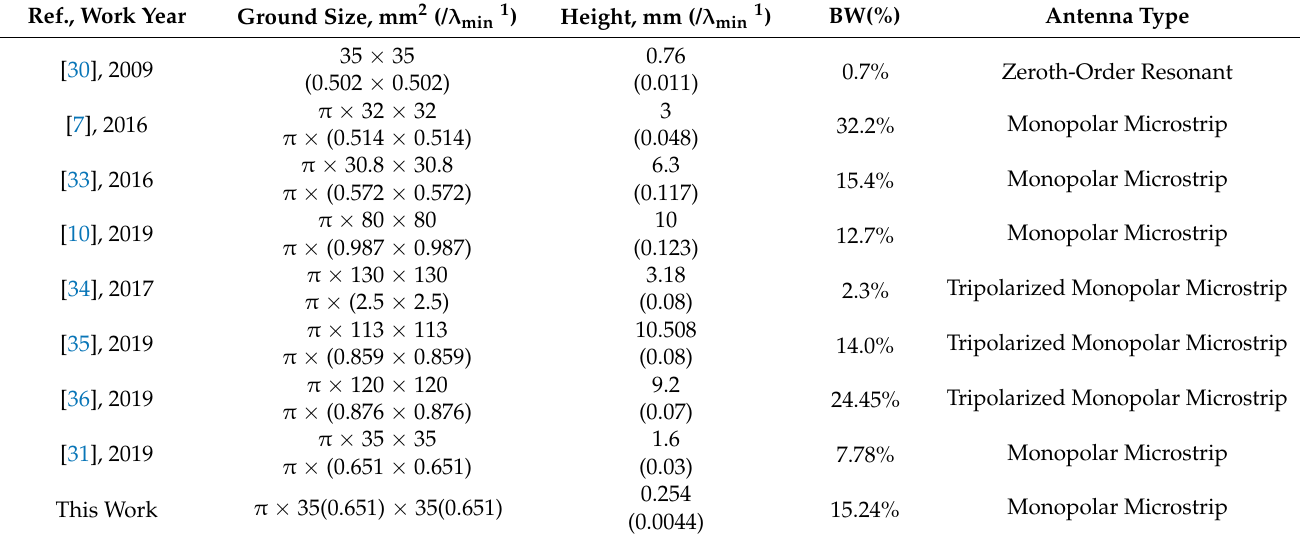
Table 2. Performance comparison of state-of-the-art monopolar microstrip